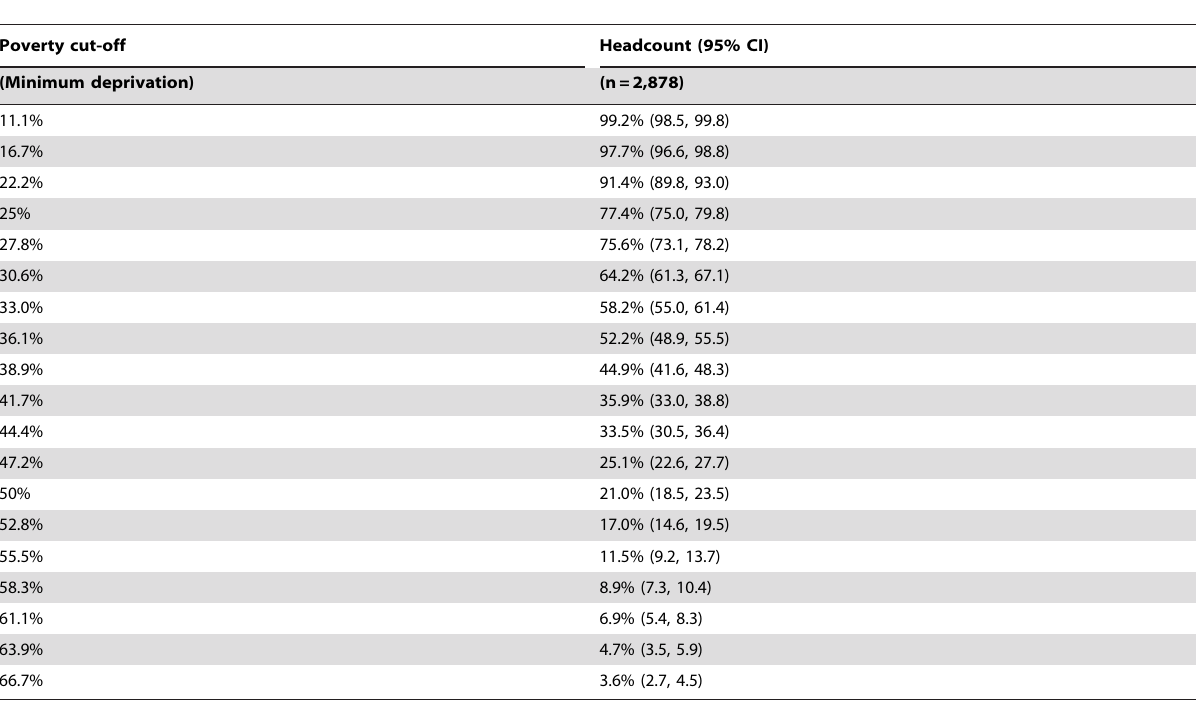
Table 3. Poverty Distribution of Zambe´zia Province, Districts of Morrumbala, Namacurra, and Alto Molo´cue`.